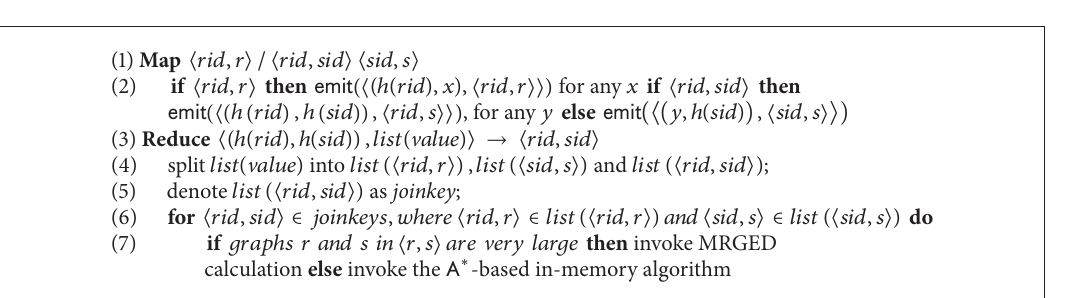
Algorithm 4: Replacement of verification of Algorithm